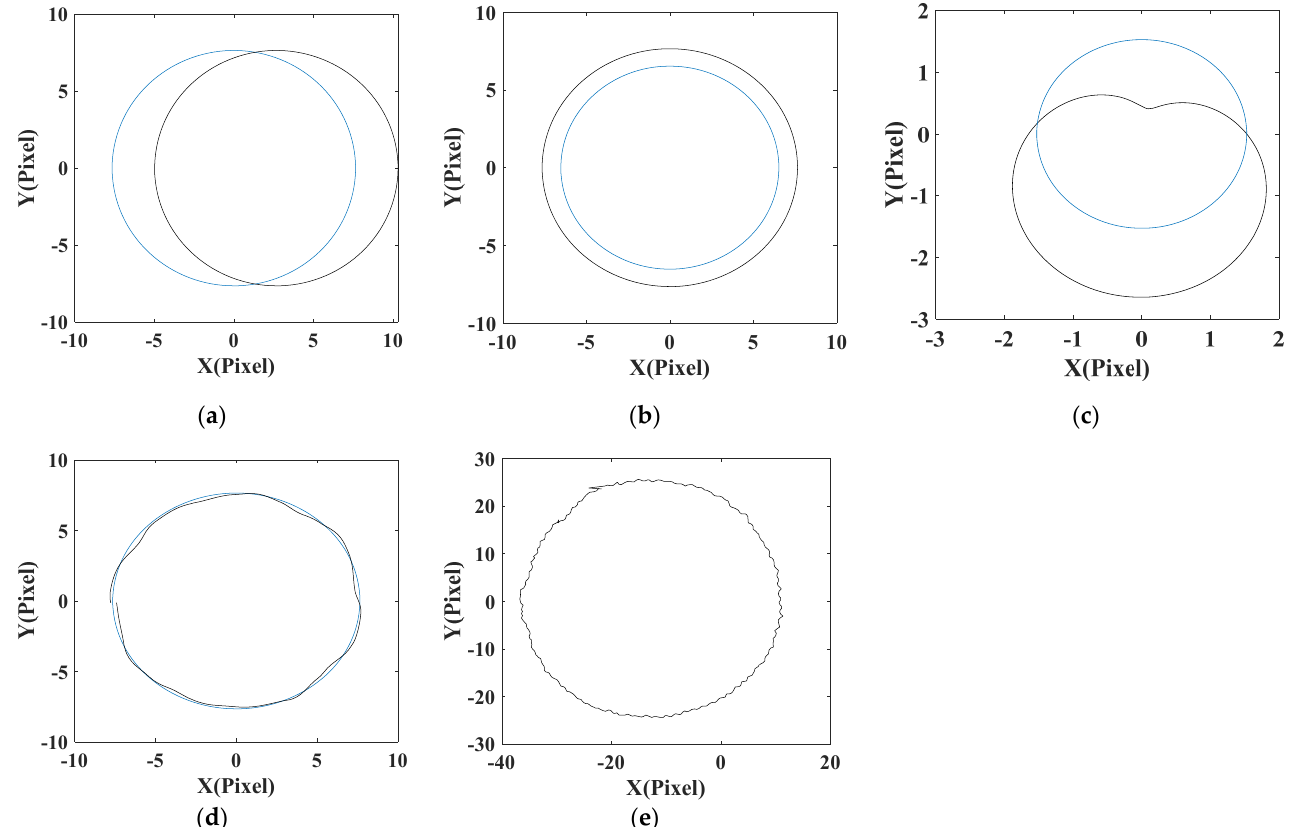
Figure 5. Impact of errors on the outgoing beam. The blue curve is the ideal TLS and the black curve is the TLS with error impacts. ( a ) Beam-pointing field deviation caused by the incident light tilt. ( b ) Beam-pointing field radius increase caused by prism tilt. ( c , d ) Beam-pointing field displacement and TLS distortion caused by the prism rotation axis tilt error; the prism rotation axis tilt is constant in ( c ), and this error is a function of the prism rotation angle in ( d ). ( e ) The actual TLS obtained in